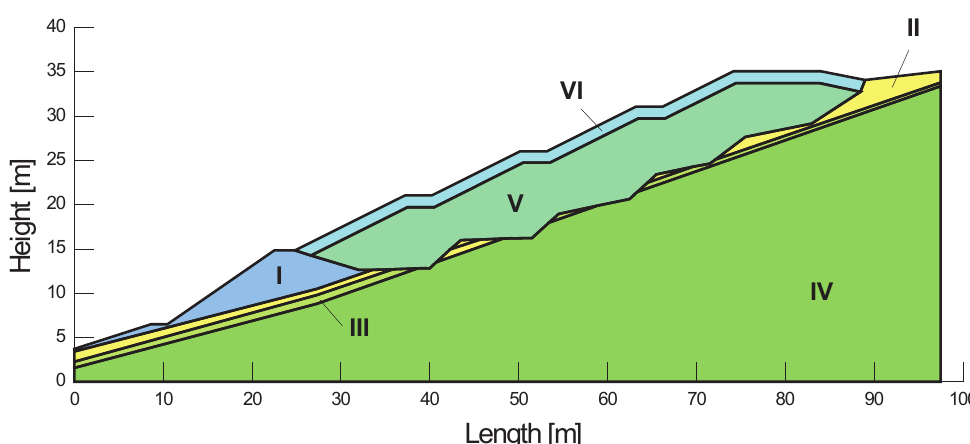
Figure 1 : Landfill cross-section. I – retaining embankment, II – geotechnical layer II, III – geotechnical layer III, IV – geotechnical layer IV, V – municipal waste and VI – organic